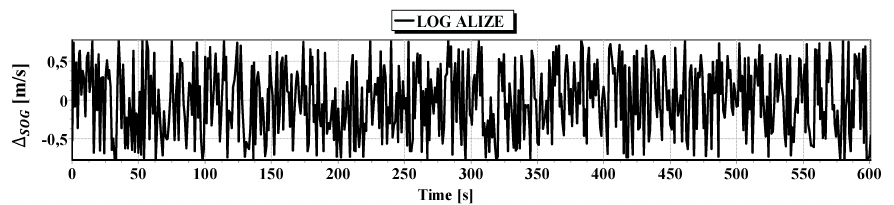
Figure 10. Graph of simulated measurement error ∆ SOG .